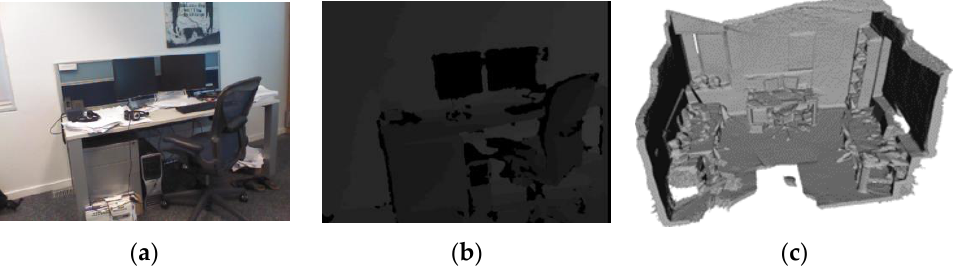
Figure 3. Three types of the data provided by Microsoft 7 Scenes Dataset: ( a ) RGB image, ( b ) depth image, and ( c ) TSDF volume for scene reconstruction [119]. image, and ( c ) TSDF volume for scene reconstruction